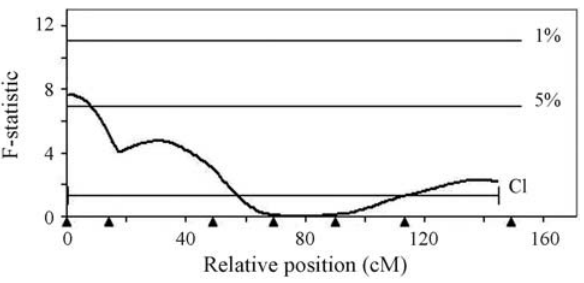
Figure 1 - Chromosome F-statistic distribution for the birth weight quan- titative trait locus (QLT) on the chromosome 14 (BTA14). The arrows be- low the X axis indicate marker positions on the chromosome as measured from the centromere, in centimorgans (cM): CSSSM066 (0.0 cM), ILSTS011 (16.9 cM), BMC1207 (47.8 cM), BMS740 (67.7 cM), BMS1899(91.6cM),BL1036(116.8cM)andBMS2055(144.3cM).The upper and lower horizontal lines represent threshold levels of 1% (F = 11.33) and 5% (F = 7.20). The QTL is located at 1.0 cM from the centromere (F = 7.62). The scale indicates the 95% confidence interval (0.0 cM to 144.0